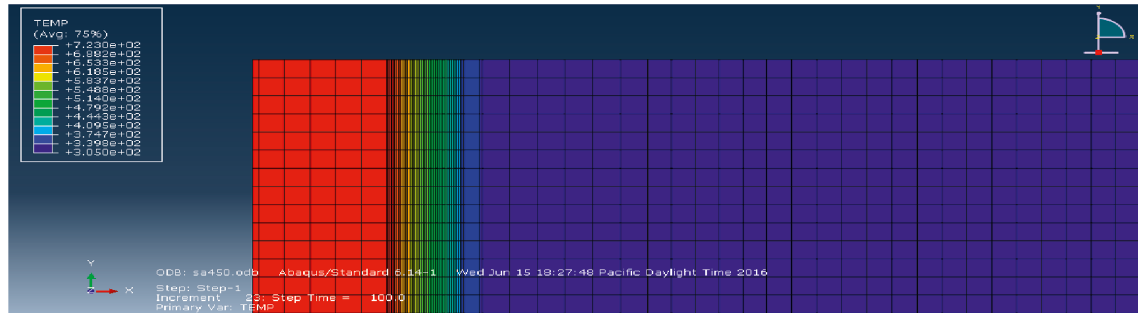
Figure 16: Showing thermal gradient for nodal